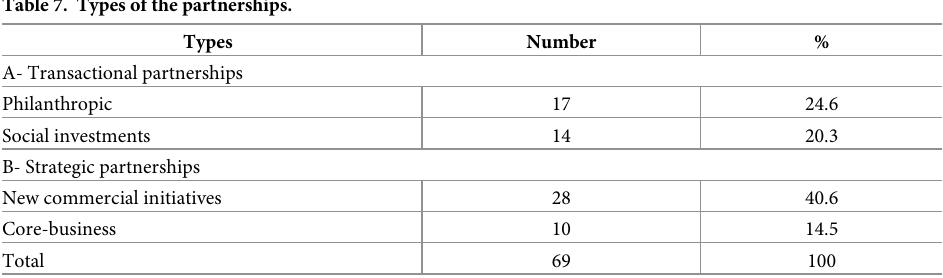
Table 7. Types of the partnerships.